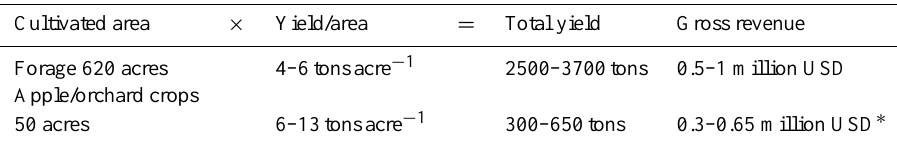
Table 1. Approximate cultivated acreage (D. Archuleta, personal communication, 2012), yield, and gross revenue ranges (Forage, Currier et al., 1995; Lauriault et al., 2004; Apple/Orchard crops, S. Yao, personal communication, 2012) of two crops and potential effects from various factors (Acequia de